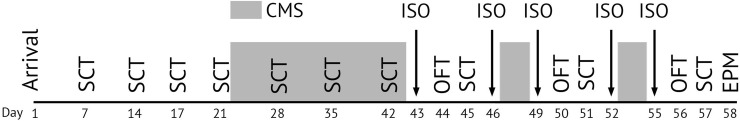
Study timeline showing stress induction, isoflurane anesthesia administration and behavioral testing.CMS = chronic mild stress, EPM = elevated plus maze, ISO = isoflurane anesthesia, OFT = Open field test, SCT = sucrose consumption test.